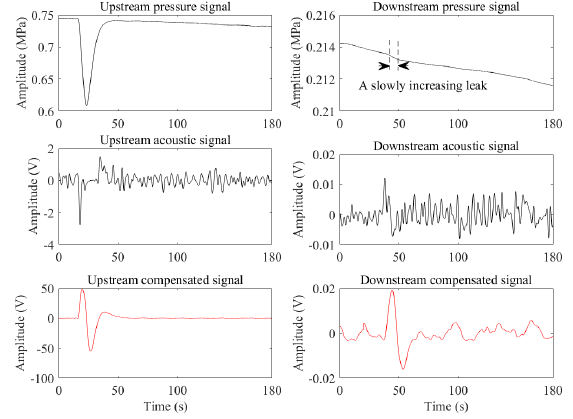
Figure 13. The case of the pressure falling.